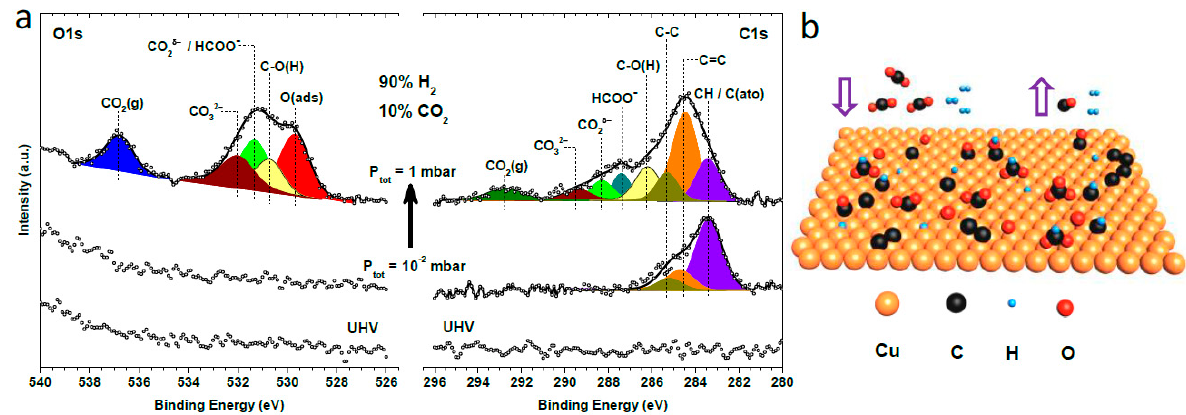
Figure 8. The schematic of catalytic hydrogenation of CO 2 to CH 3 OH on Cu(111) surface. ( a ) NAP- XPS spectra of C 1s (right) and O 1s (left). All spectra were obtained at fixed CO 2 and H 2 ratio XPS spectra of C 1s ( right ) and O 1s ( left ). All spectra were obtained at fixed CO 2 and H 2 ratio (P(CO 2 )/P(H 2 ) = 1/9) and a total pressure of ultrahigh vacuum (UHV) (lower panel), 10 − 2 mbar (mid- (P(CO 2 )/P(H 2 ) = 1/9) and a total pressure of ultrahigh vacuum (UHV) ( lower panel), 10 − 2 mbar dle panel), and 1mbar (upper panel), respectively. ( b ) The schematic illustration. Reprinted with ( middle panel), and 1mbar ( upper panel), respectively. ( b ) The schematic illustration. Reprinted with permission from ref. [214]. Copyright 2018 Wiley. permission from ref. [214]. Copyright 2018